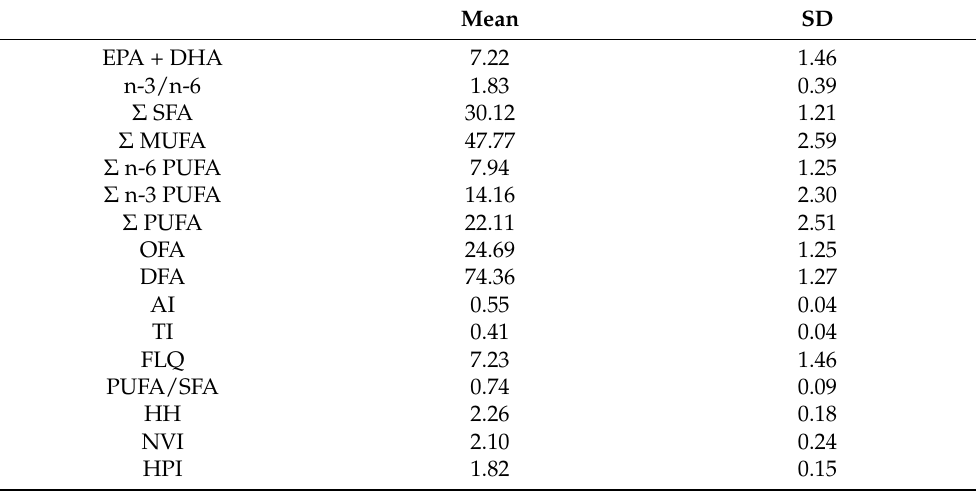
Int. J. Environ. Res. Public Health 2023 , 20 , 2257 14 of 25